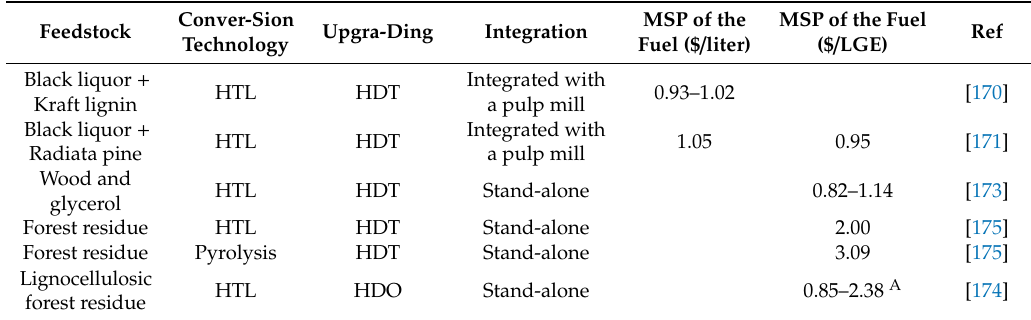
Table 12. MSP of biofuels produced with di ff erent biomass inputs. The last four values are for comparison. The table is edited and updated from Ong et al.